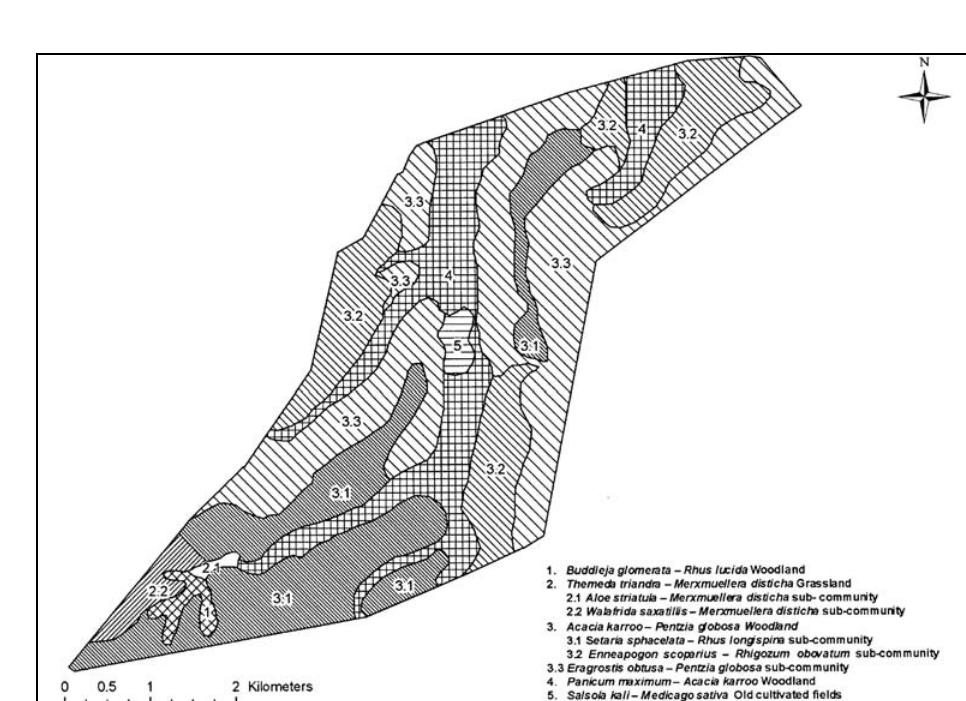
Fig. 2. The plant communities of the Ebenhaezer section of the Mountain Zebra National